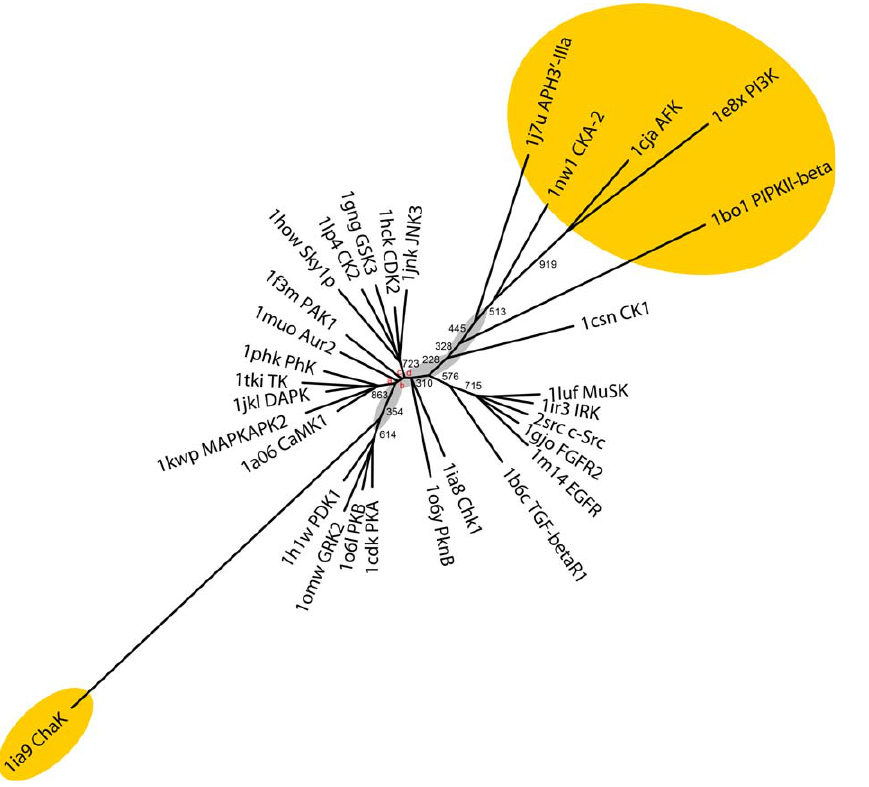
Figure 6. Conventional Distance-Based Phylogenetic Tree of the Kinase-Like Superfamily, Based Only on the Sequence Alignment from Figure 3 This tree did not explicitly incorporate structural information, and is provided for purposes of comparison with the Bayesian tree presented in Figure 4. Structures are labeled by their PDB IDs, followed by the abbreviated name of the structure. The AKs are highlighted by orange ovals. Bootstrap values are provided for major branches. Some branches are too short for values to fit; these are marked with red letters that correspond to the following values: a, 199; b, 170; c, 101; d, 141. Branches highlighted in gray were not supported by bootstrap values above 500, and should be considered speculative (if based only on this tree data) [57,58]. Many of the core relationships within the superfamily cannot be resolved with confidence using the conventional sequence-based approach. DOI: